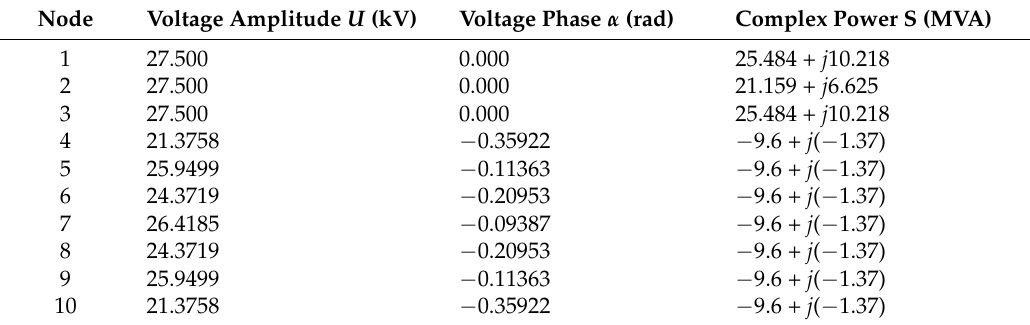
Table 2. The power flow calculation results of ACTPSS.